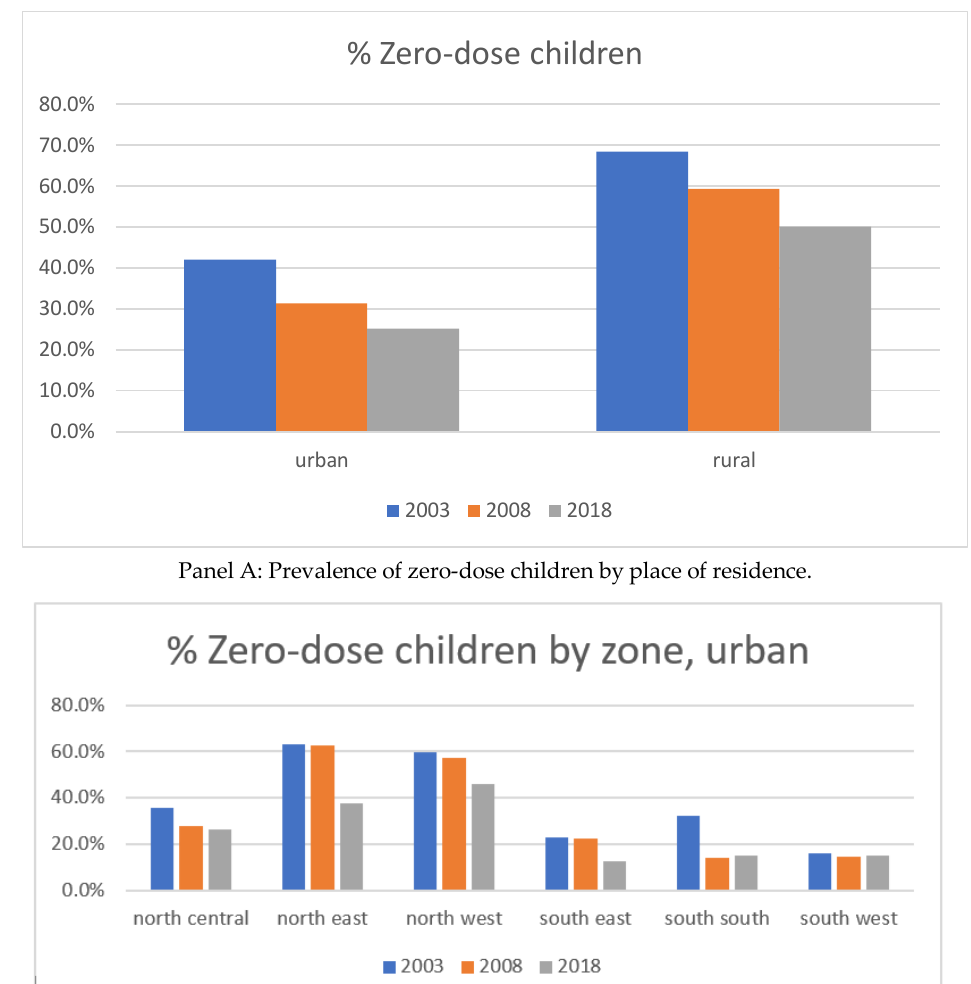
Panel B: Prevalence of zero-dose children by zone, urban areas.